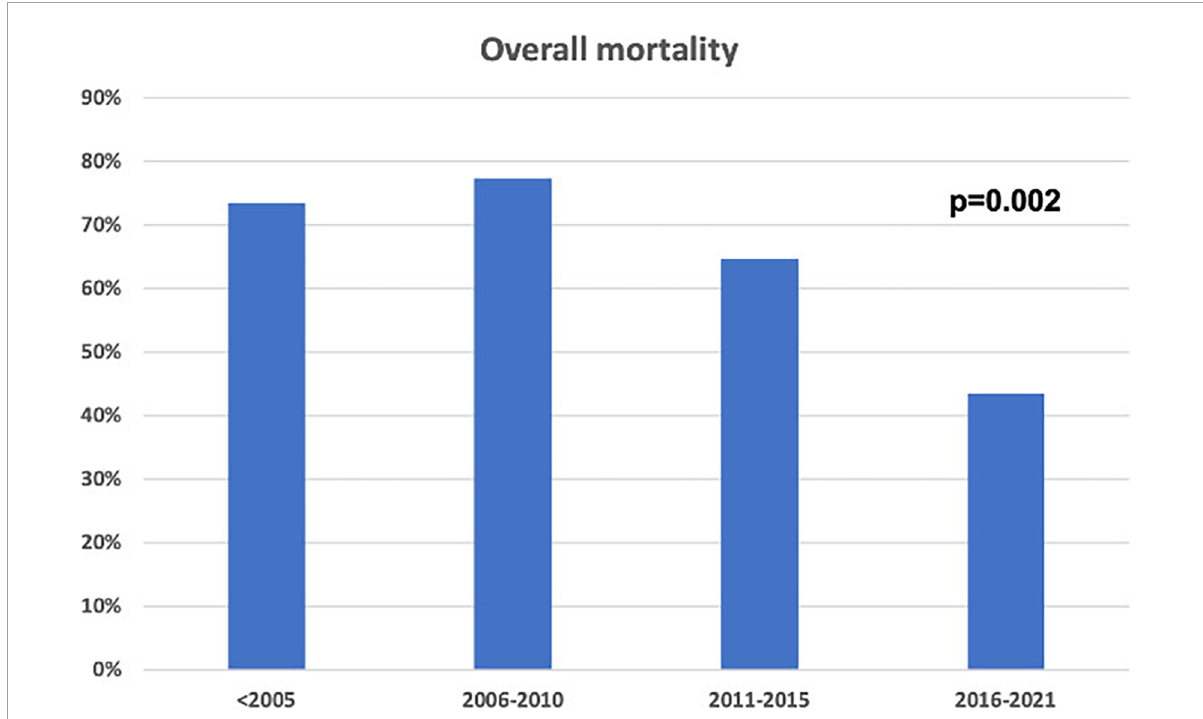
FIGURE2 Overall mortality in the study population according to enrolment